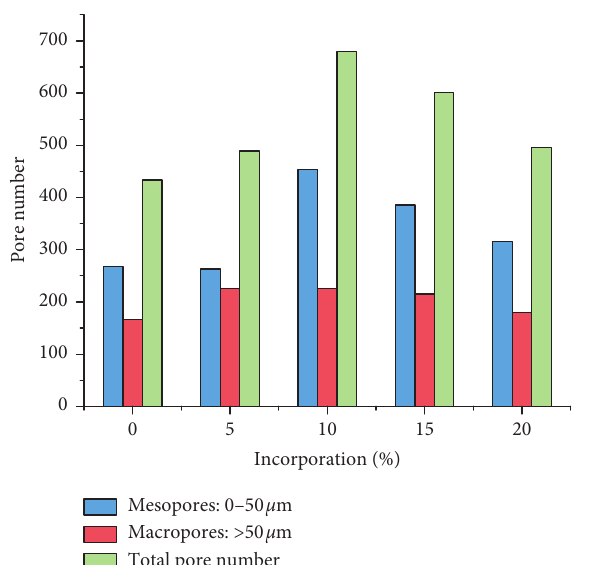
Figure 8: Distributions of mesopores and macropores in the calcium carbonate-doped red clay samples with different calcium carbonate contents.